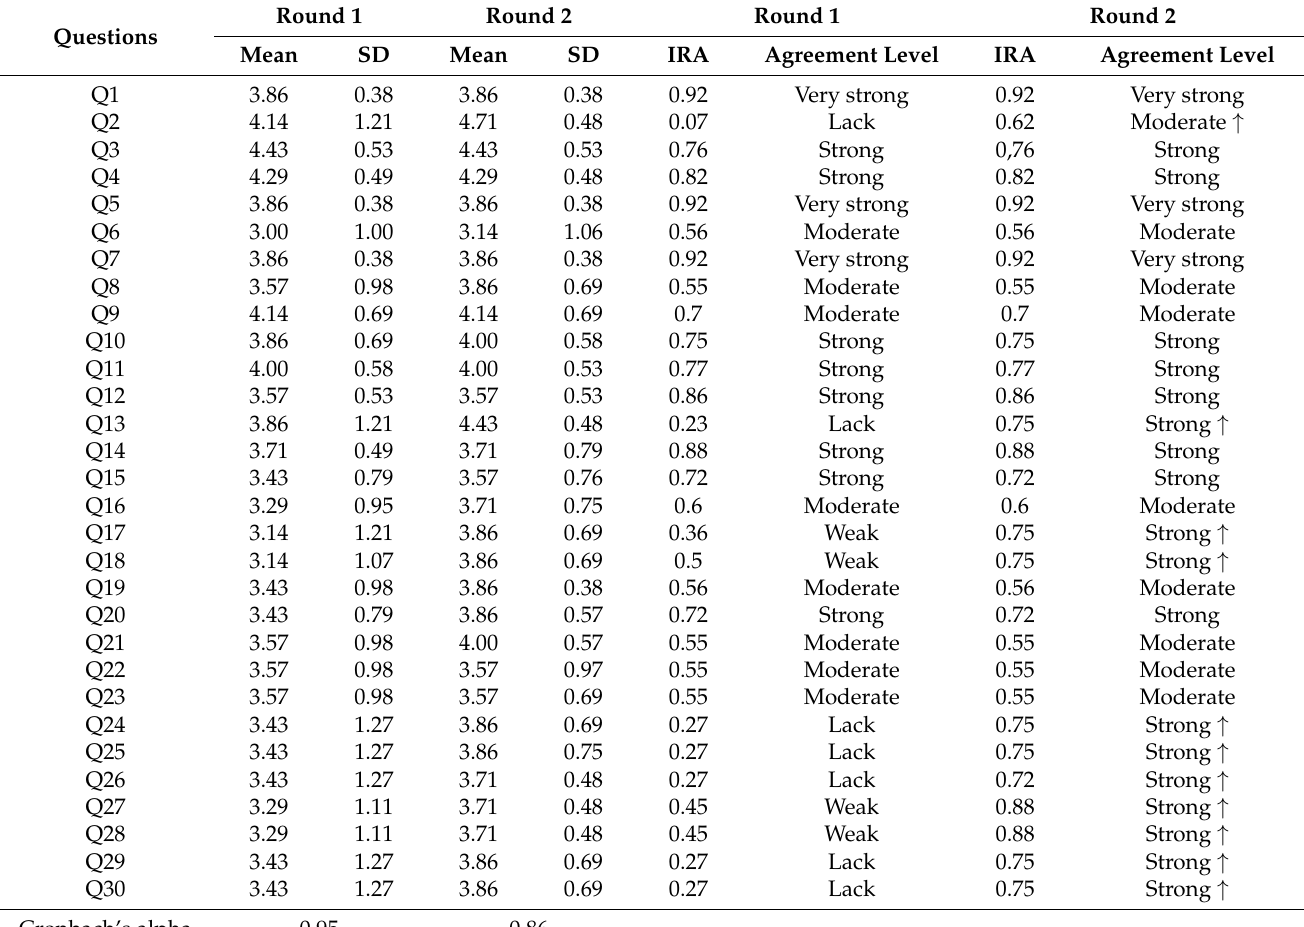
Table 6. Mean, standard deviation, and IRA analysis of first and second rounds of Delphi